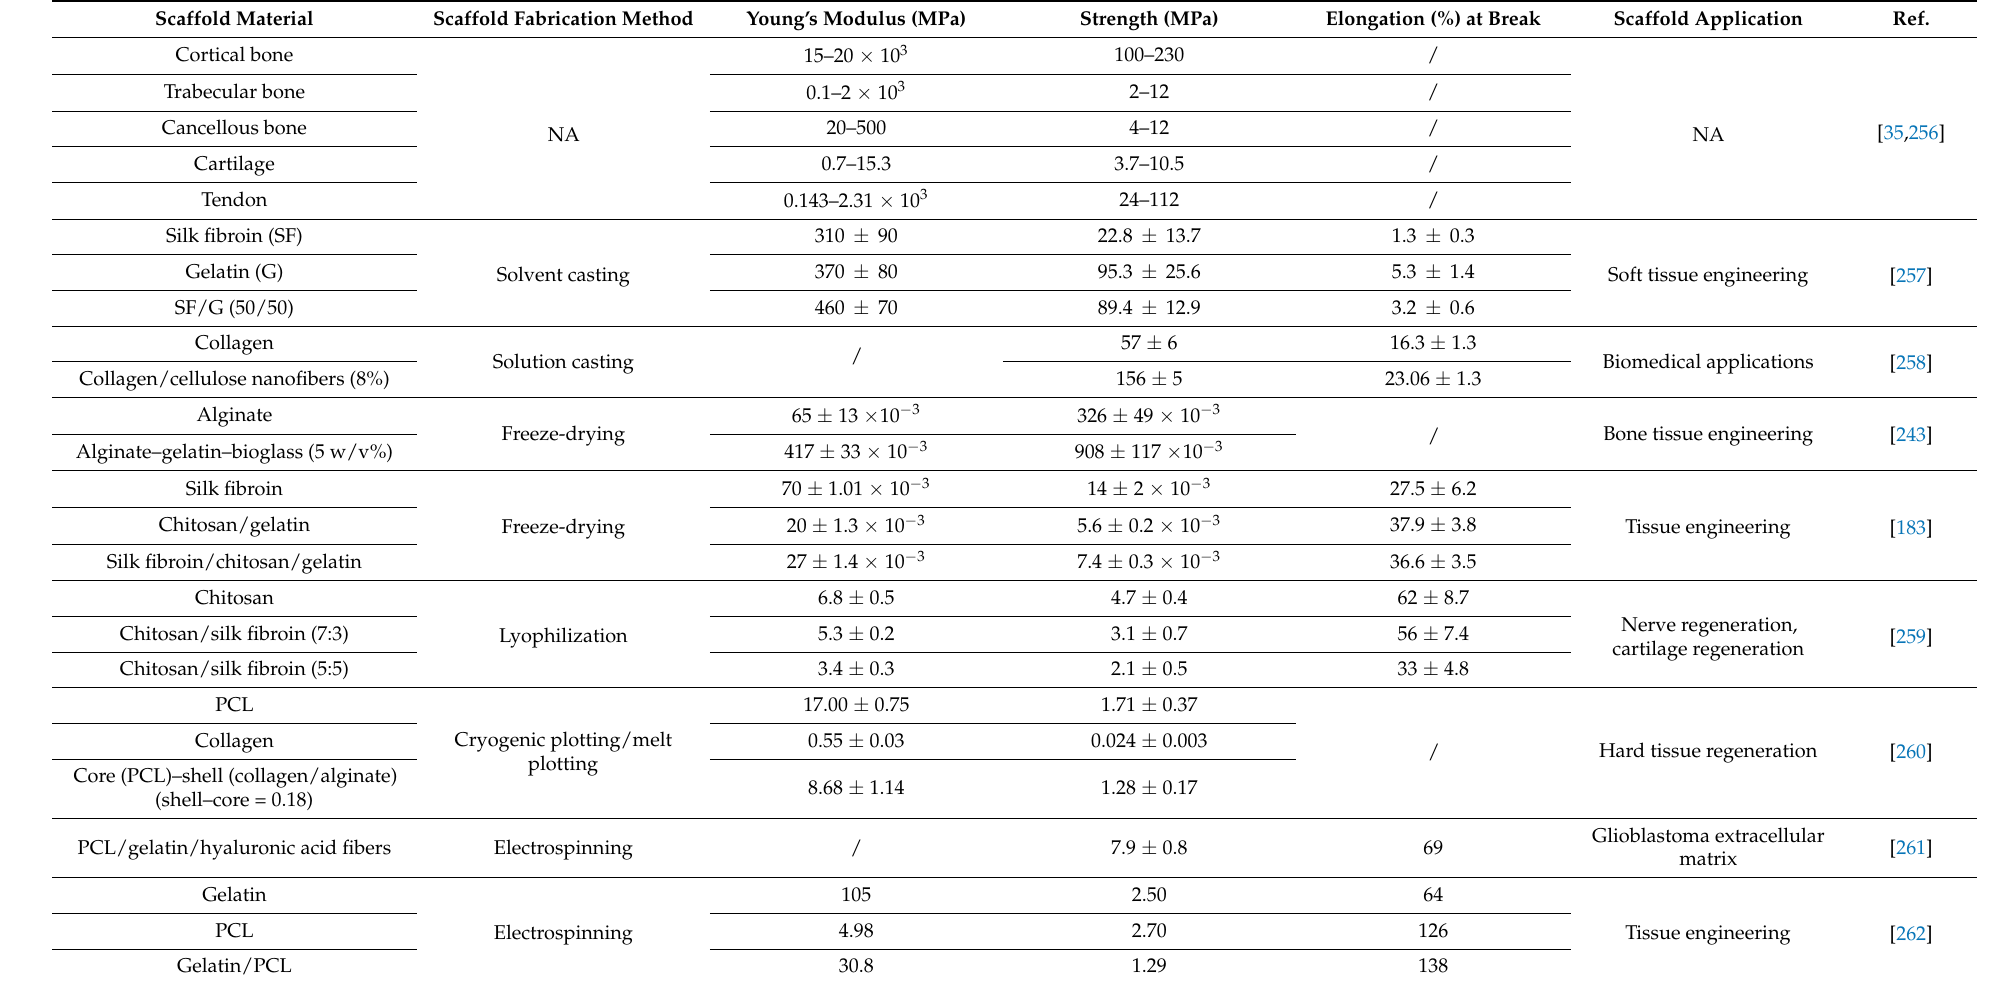
Table 6. Mechanical properties of scaffold